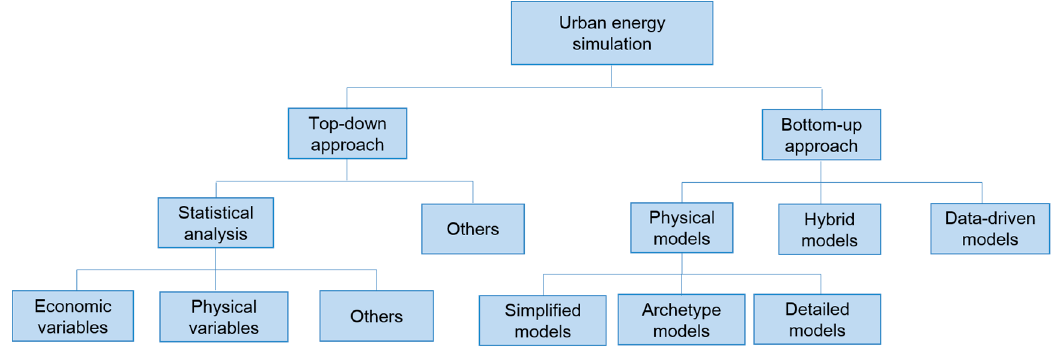
Figure 1. Classification of urban energy simulation methodology.